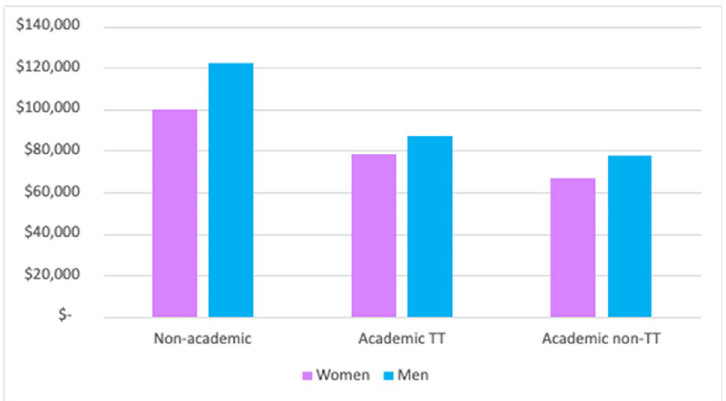
Fig 3. Average salaries for men and women 7–9 years after graduation, by job type. Notes : Analyses based on data from the National Survey of Earned Doctorates and National Survey of Doctoral Recipients.